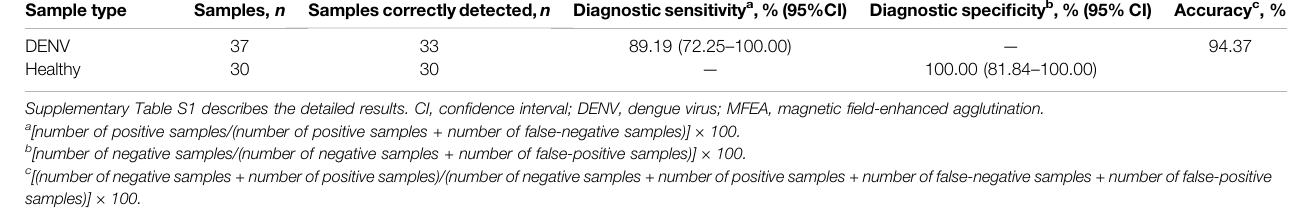
TABLE 1 | Molecular MFEA readout on biological samples.